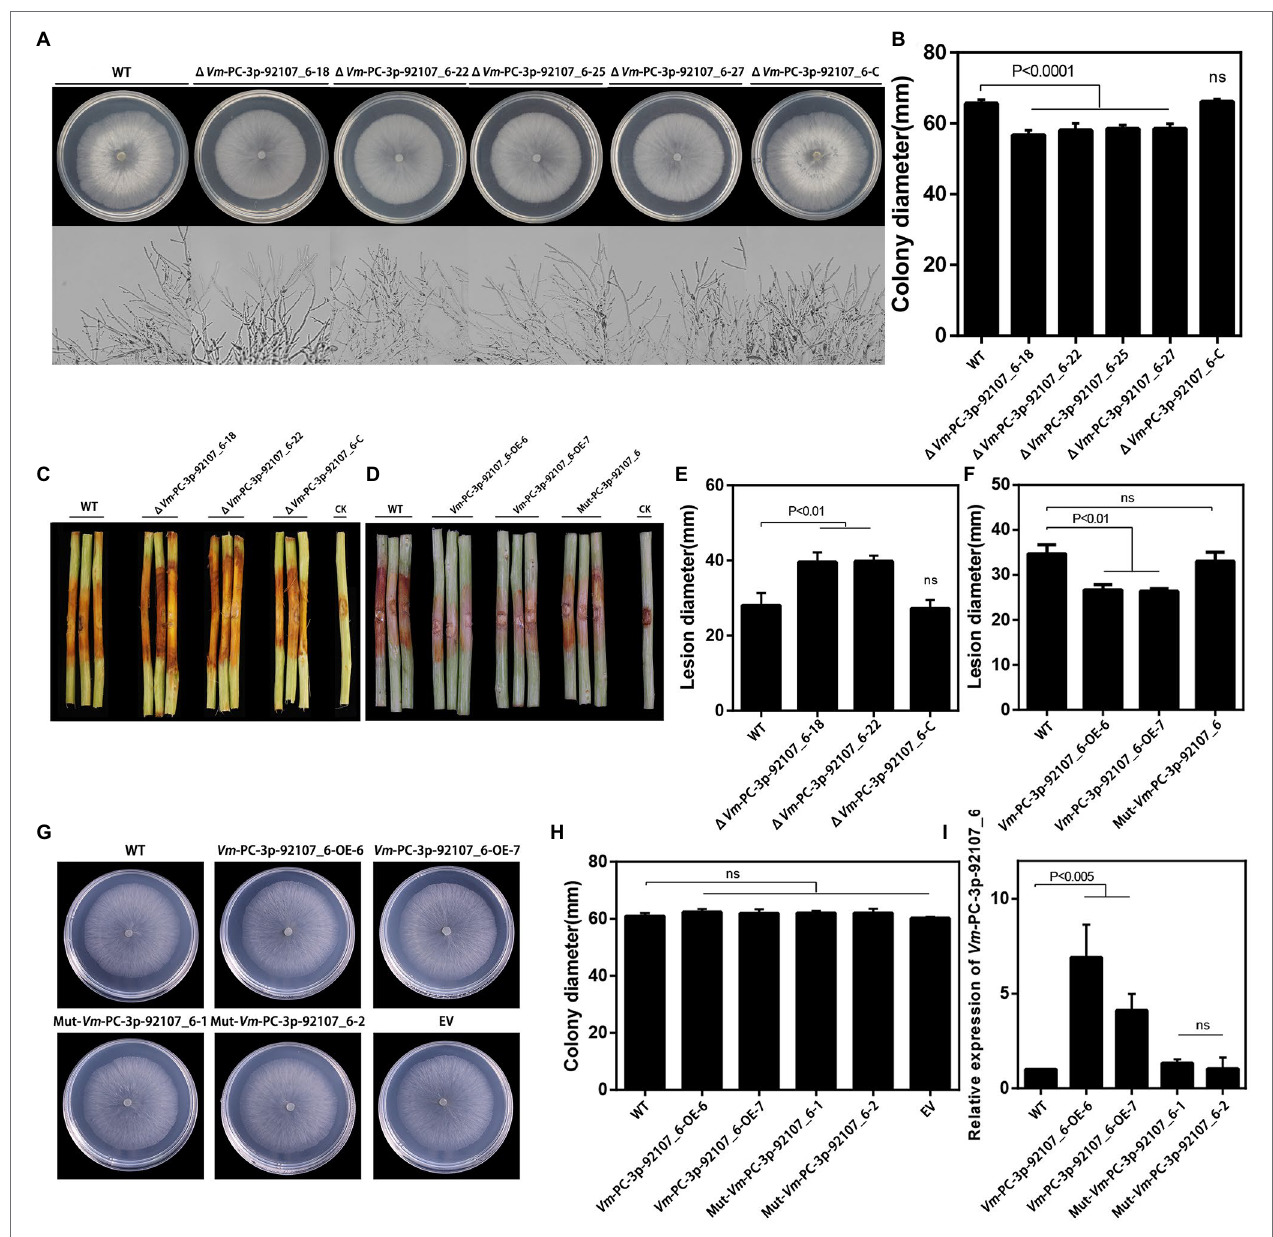
FIGURE 3 | Phenotypical analysis of Vm -PC-3p-92107_6 deleted mutants ( Δ Vm -PC-3p-92107_6), complement transformants ( Δ Vm -PC-3p-92107_6-C), over- expression transformants ( Vm -PC-3p-92107_6-OE), and the wild type (WT). (A) and (B) Colony morphology of WT, Vm -PC-3p-92107_6 deleted mutants ( Δ Vm -PC- 3p-92107_6–18, Δ Vm -PC-3p-92107_6–22, Δ Vm -PC-3p-92107_6–25, and Δ Vm -PC-3p-92107_6–27), and complement transformants ( Δ Vm -PC-3p-92107_6-C) after 48 h (hr) incubation in PDA at 25 ° C. Related colony diameters were measured after 48 h incubation. Data represent mean ± SD. The experiment was repeated three times, each time with three plates. (C) and (E) Pathogenicity test of WT, Δ Vm -PC-3p-92107_6–18, Δ Vm -PC-3p-92107_6–22, and Δ Vm -PC-3p-92107_6-C after 5 days post-inoculation. Three representative diseased twigs are shown. The pathogenicity test was independently repeated three times, each time with six replicates. CK represents a negative control. Data represent mean ± SD. (D) and (F) Pathogenicity test of WT, Vm -PC-3p-92107_6-OE-6, Vm -PC-3p-92107_6- OE-7, and Mut- Vm -PC-3P-92107_6 after 5 dpi. Three representative diseased twigs are shown. The pathogenicity test was independently repeated three times, each time with six replicates. CK represents a negative control. Data represent mean ± SD. (G) and (H) Colony morphology of WT, Vm -PC-3p-92107_6 over- expression transformants ( Vm -PC-3p-92107_6-OE-6 and Vm -PC-3p-92107_6-OE-7), mutated Vm -PC-3p-92107_6 (Mut- Vm -PC-3P-92107_6–1 and Mut- Vm -PC- 3P-92107_6–2), and empty vector transformant (EV) after 48 h incubation in PDA at 25 ° C. Related colony diameters were measured after 48 h incubation. Data represent mean ± SD. The experiment was repeated three times, each time with three plates. (I) The relative expression level of Vm -PC-3p-92107_6 in WT, Vm -PC- 3p-92107_6 over-expression transformants ( Vm -PC-3p-92107_6-OE-6 and Vm -PC-3p-92107_6-OE-7), and mutated Vm -PC-3p-92107_6 (Mut- Vm -PC- 3P-92107_6-1 and Mut- Vm -PC-3P-92107_6-2). Vm -U6 was selected to reference, the relative expression level of WT is set to 1 as control group using the 2 - ΔΔ Ct method. Data represent mean ±